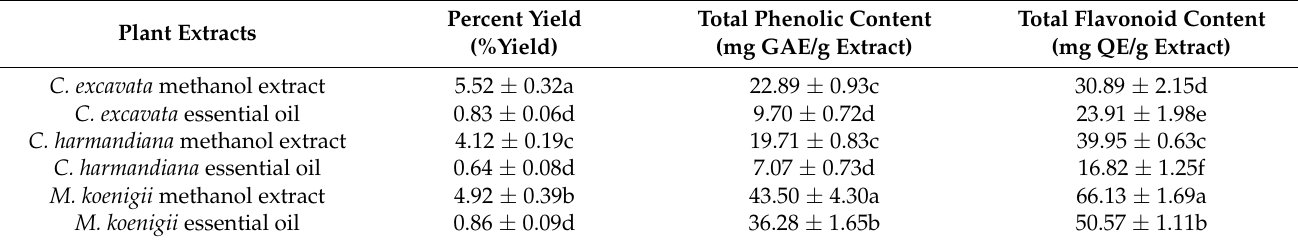
Table 2. Total phenolic and total flavonoid contents of methanol extract and essential oil of Clausena excavata , Clausena harmandiana and Murraya koenigii . Plant